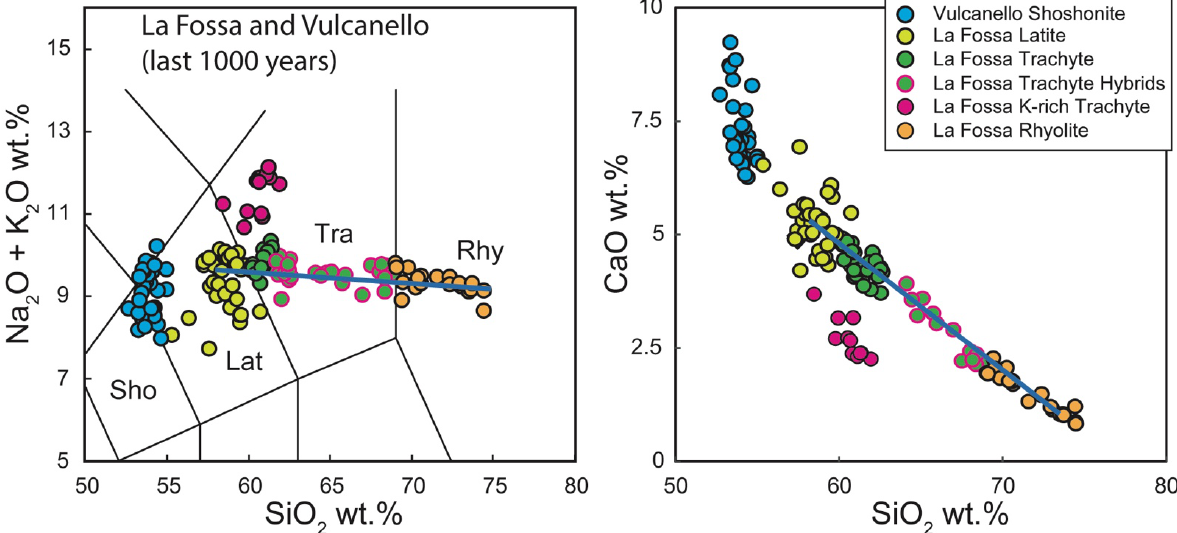
Figure 2. Total alkali vs. SiO 2 and CaO vs. SiO 2 (wt.%) for the products of the last 1000 years of La Fossa and Vulcanello. Literature data from [19–22,27,35–41]. The straight lines in diagrams visually indicate the mixing trend between latitic and rhyolitic magmas, as suggested by [19,22]. The products showing evident textural mixing features and constant alkali (Trachyte Hybrids) plot along this line. See the Supplementary Table S1 for the complete data set. Major elements are recalculated to 100 wt.% on anhydrous basis.